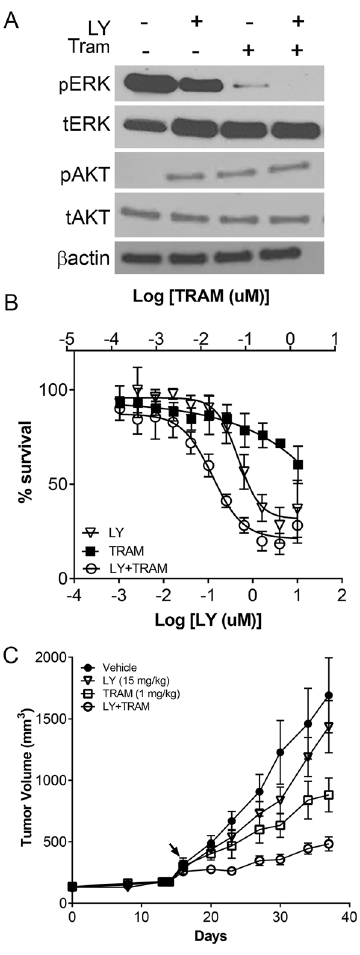
Figure 5. Organoid OCIP256 with KRAS wt and putative actionable BRAF had activated phospho-ERK (pERK) and phospho-AKT (pAKT). ( A ) Levels of pERK decreased with either LY3009120 (LY) and/or trametinib (Tram) treatments. Original scanned films are shown in Supplementary Fig. S8. ( B ) Inhibition of XDO tumor cell growth was measured with drug treatments, LY3009120 (10–0.001 uM), trametinib (1.25–0.0001 uM), or combined LY:Tram at 8:1ratio. ( C ) Drug sensitivities were evaluated in its parent PDX